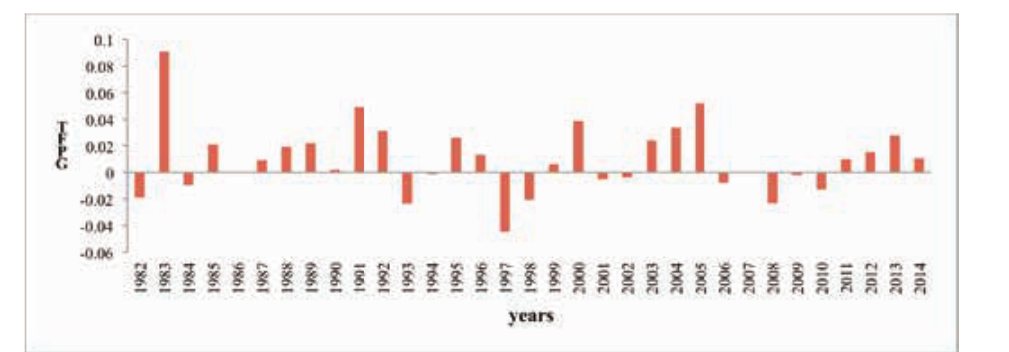
Figure 6: Trend of Total Factor Productivity Growth (TFPG)